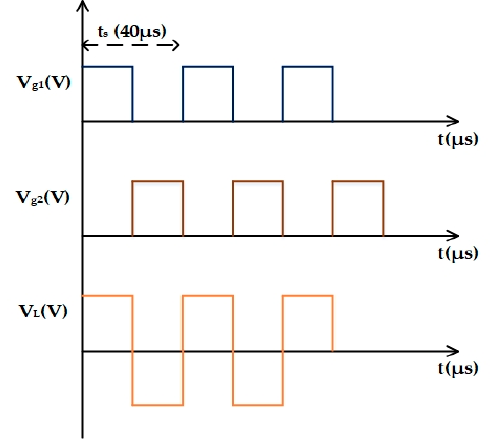
Figure 6. Theoretical voltage waveforms for ferrous heating mode. Based on the pulses, it was evident that the switches S1 and S2 worked alternatively. through S1, L r , R pot , C r1 , and S3. After that, switch S1 was turned off, and S2 was